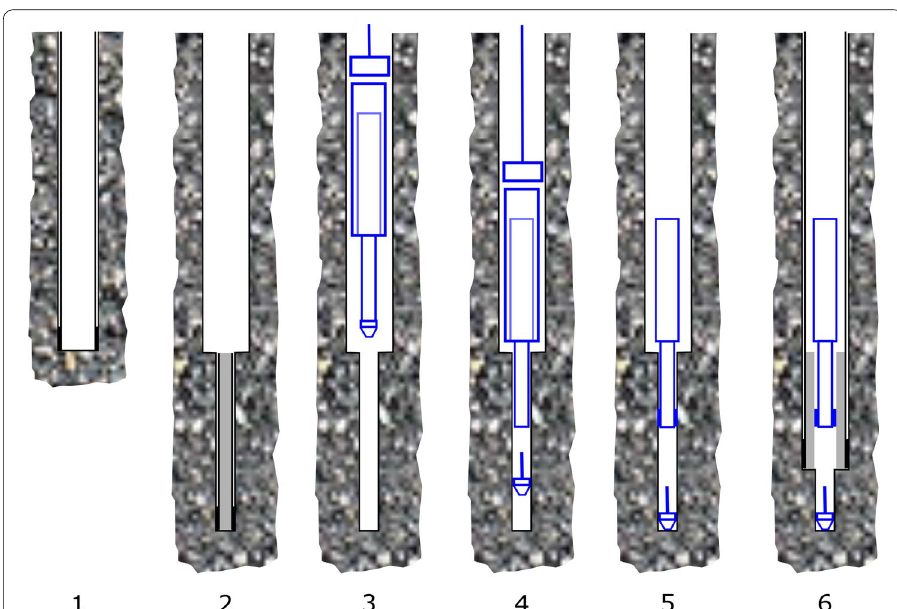
Fig. 4 Implementation of the overcoring method on the example of the Borre probe (Sjöberg and Klasson 2003); the principles can be applied to any overcoring method (Sjöberg et al. 2003). Figure and description was adapted from Sjöberg et al. (2003). (1) Drill main borehole (76 mm diameter) to measurement depth. Grind borehole bottom using a planing tool. (2) Drill pilot hole (36 mm diameter) and recover the core for appraisal. Flush the borehole to remove drill cuttings. (3) Apply glue to strain gauges. Insert the probe with installation tool into hole. (4) Let the probe tip with strain gauges enter the pilot hole. Release the probe from installation. A compass released at the same time is recording the installed probe orientation. Gauges are bonded to pilot hole wall. (5) Pull out installation tool and retrieve to surface. The probe is bonded in place. (6) Allow glue to harden overnight. Then overcore the probe and record strain data using the built-in data logger. Break the core and recover it to the